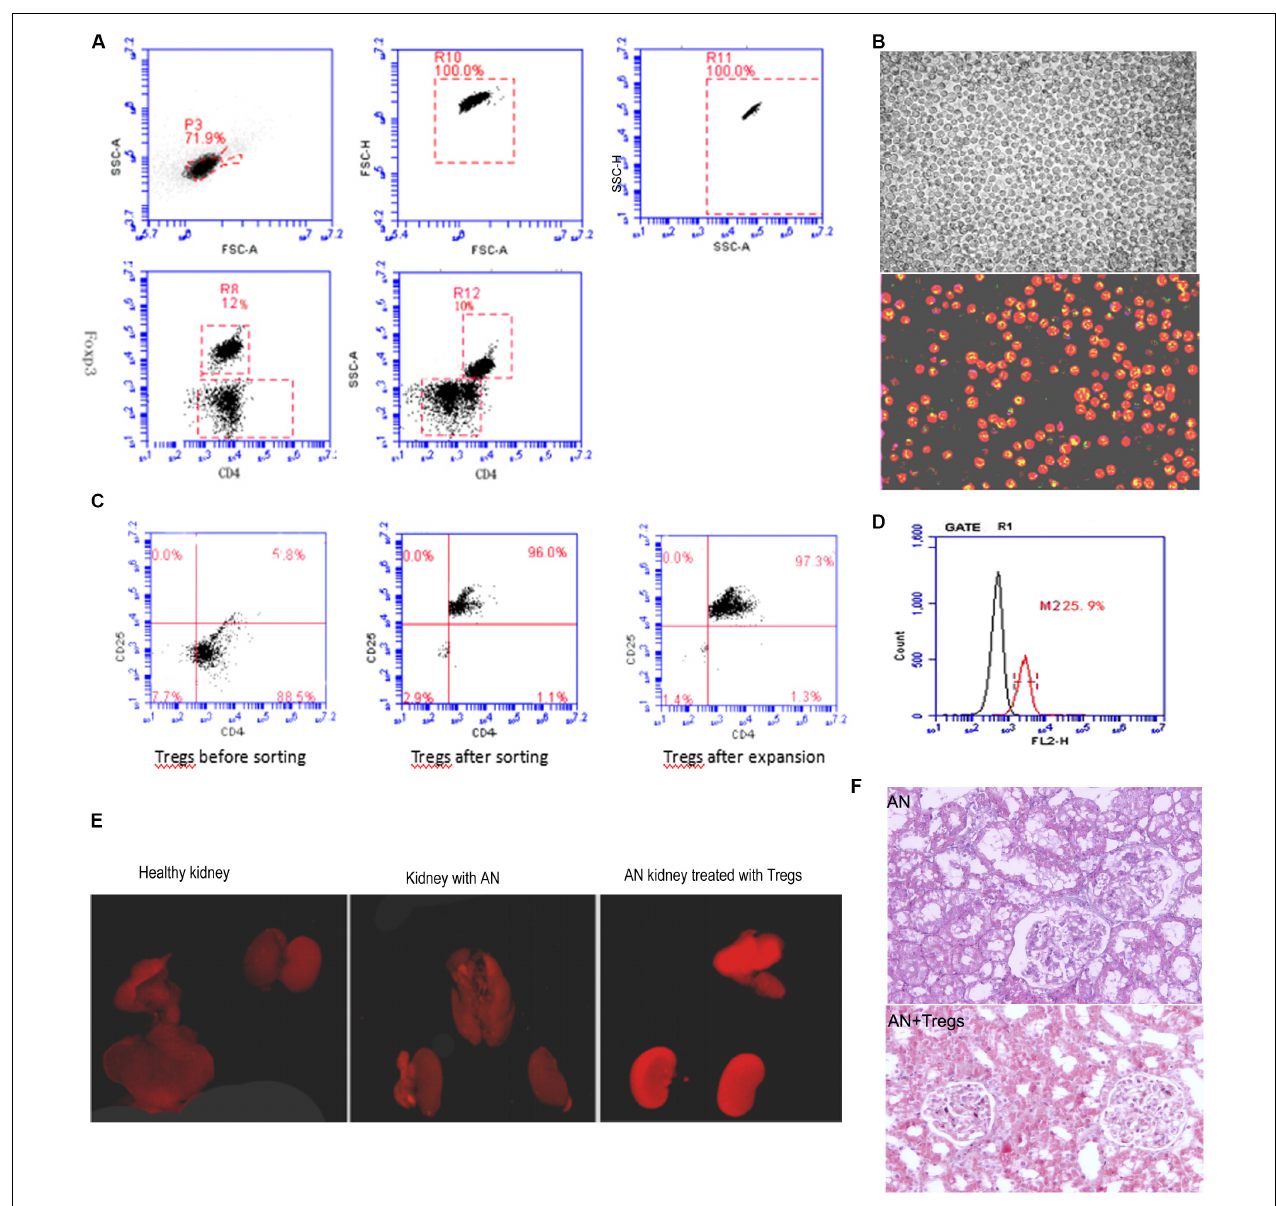
FIGURE 5 | (A) Dot plots from flow cytometry showing numbers of CD4+ CD25+ Tregs isolated from spleens of healthy mice. (B) Increase in Treg numbers after in vitro amplification. (C) Dot plots from flow cytometry showing purity of CD4+ CD25+ Tregs after amplification. (D) Flow cytometry histogram depicting Treg numbers isolated from mice with Adriamycin-induced nephropathy in which Tregs from healthy donors had been adoptively transferred. (E) Fluorescence images of kidneys from control mice, mice with Adriamycin-induced nephropathy, and mice with nephropathy after treatment with Tregs from healthy donors. (F) Histological examination suggested that kidney with AN treated with Tregs show less damage than AN. AN, Adriamycin-induced